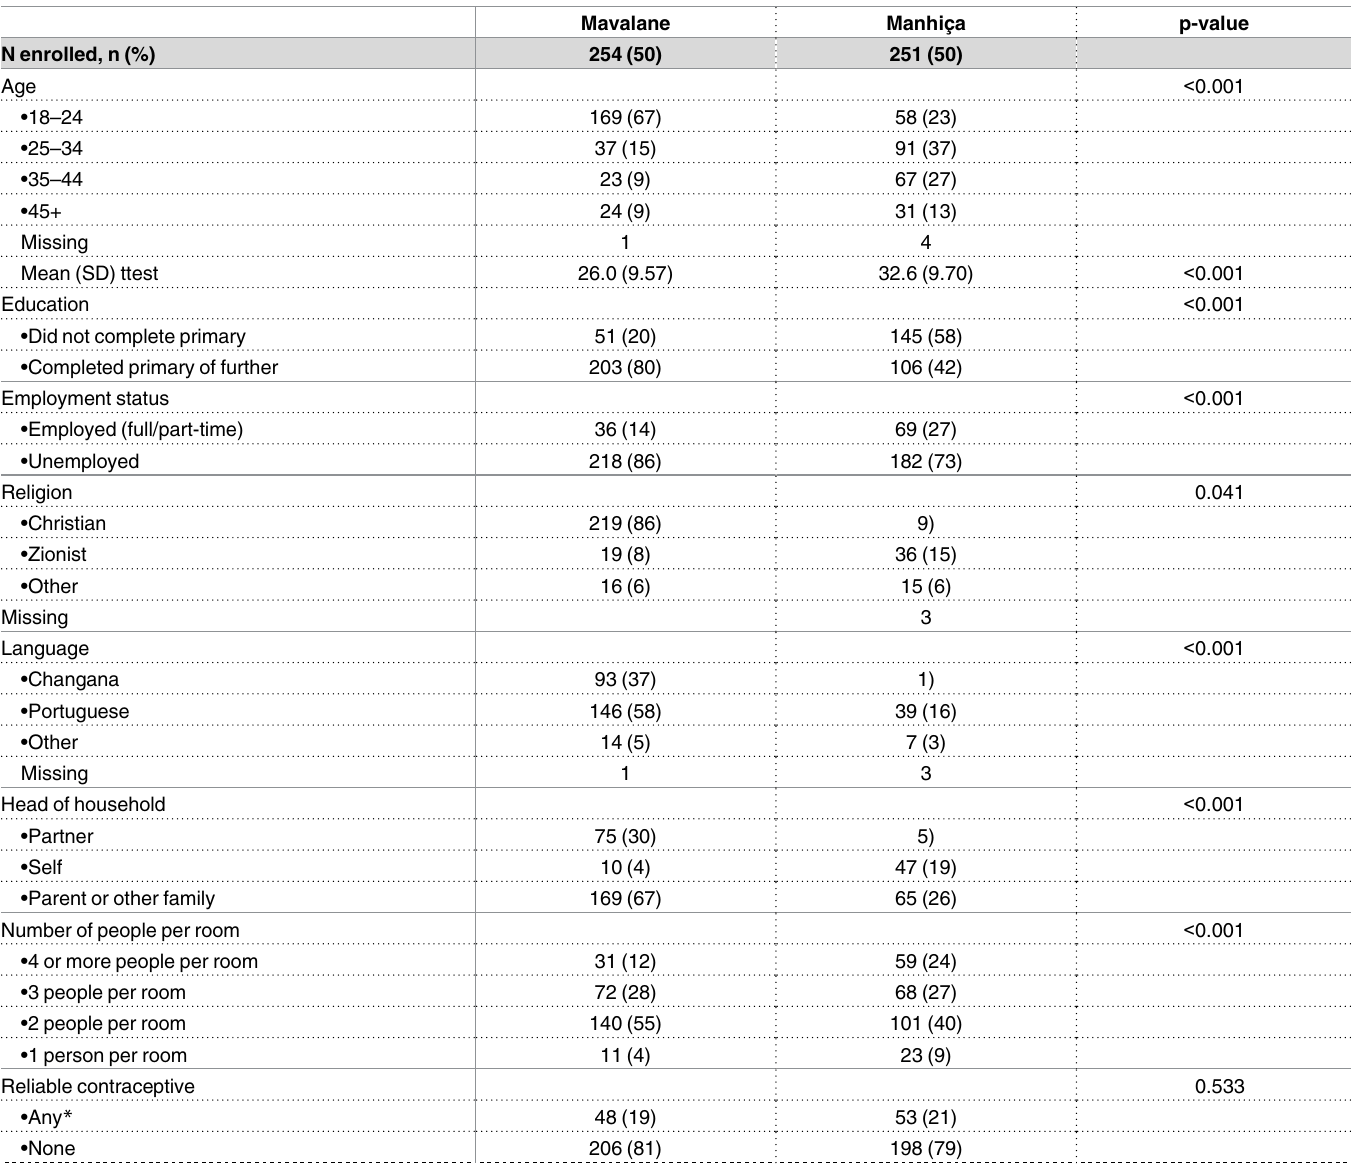
Table 3. Demographic characteristics at enrolment.